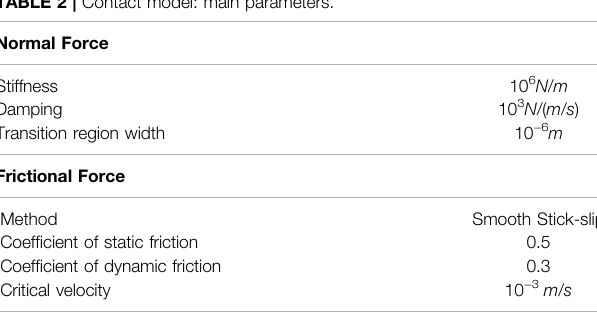
TABLE 2 | Contact model: main